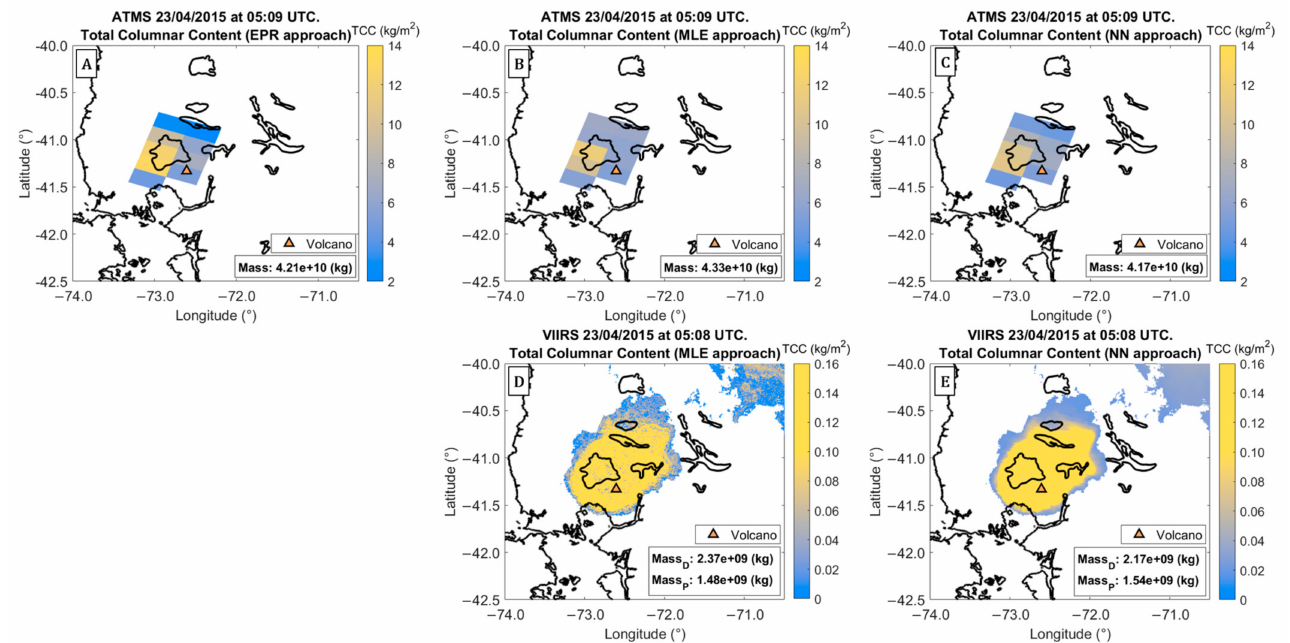
Figure 13. The Calbuco eruption on 23rd April 2015. (First row) The retrieval for the MW-MMW observations, where ( A ) the TCC map and the total mass estimates by the EPR; ( B ) the TCC map and the total mass estimates by the MLE; ( C ) the TCC map and the total mass estimates by the NN. (Second row) The retrieval for TIR observations, where ( D ) the TCC map and the total mass estimates by the MLE; ( E ) the TCC map and the total mass estimates by the NN. Mass P and Mass D refer to the proximal and distal clouds masses,